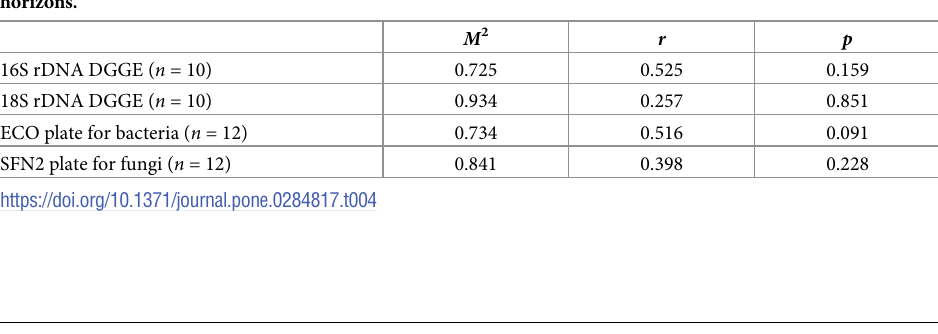
Table 4. Results of Procrustes analysis comparing PCoA ordinations for microbial properties between O and A horizons.